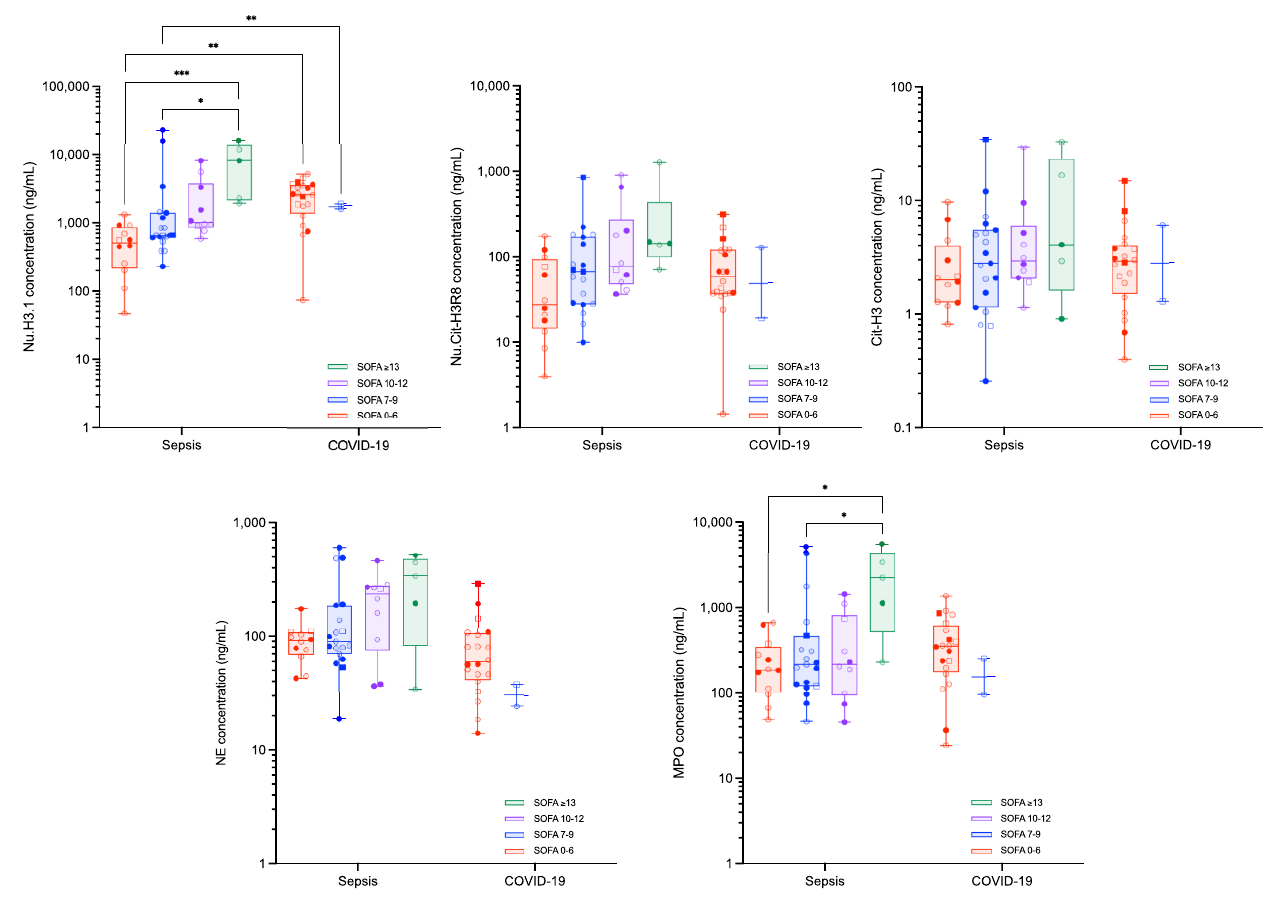
Figure 4. Circulating nucleosomes and neutrophil activation parameters in sepsis and COVID-19 subjects according to the SOFA score. Boxes represent 25th–75th percentile with median. Whiskers represent min to max variation. Squares represent patients with a thromboembolic event, and non- transparent symbols represent dead patients. *, ** and *** represent p -values ≤ 0.05, ≤ 0.01 and ≤ 0.001, respectively. Only differences that are statistically significant are reported. Abbreviations: Cit-H3, citrullinated histone H3 (citrullinated in R2, R8 and R17); MPO, myeloperoxidase; NE, neutrophil elastase; Nu.Cit-H3R8, citrullinated H3R8-nucleosome; Nu.H3.1, H3.1-nucleosomes. Table 2. Circulating nucleosome and histone parameters in septic shock and critical COVID-19 pa- tients according to APACHE-II and SOFA scores. Results are reported as median with the 10th – 90th percentile. Data are compared using an ordinary two-way ANOVA with p -value corrected for mul- tiple comparisons using a Tukey’s multiple comparisons test.